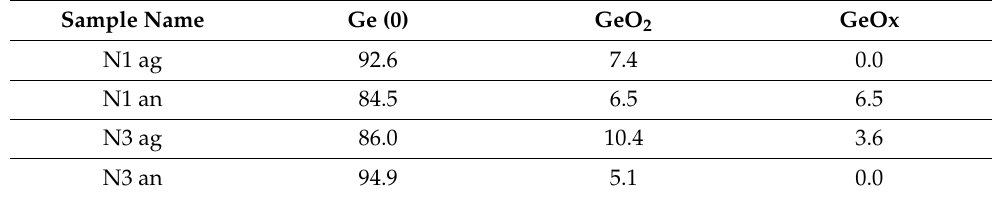
Table 4. Ge oxidation states are determined by XPS analysis. All values are given in atomic percent (at